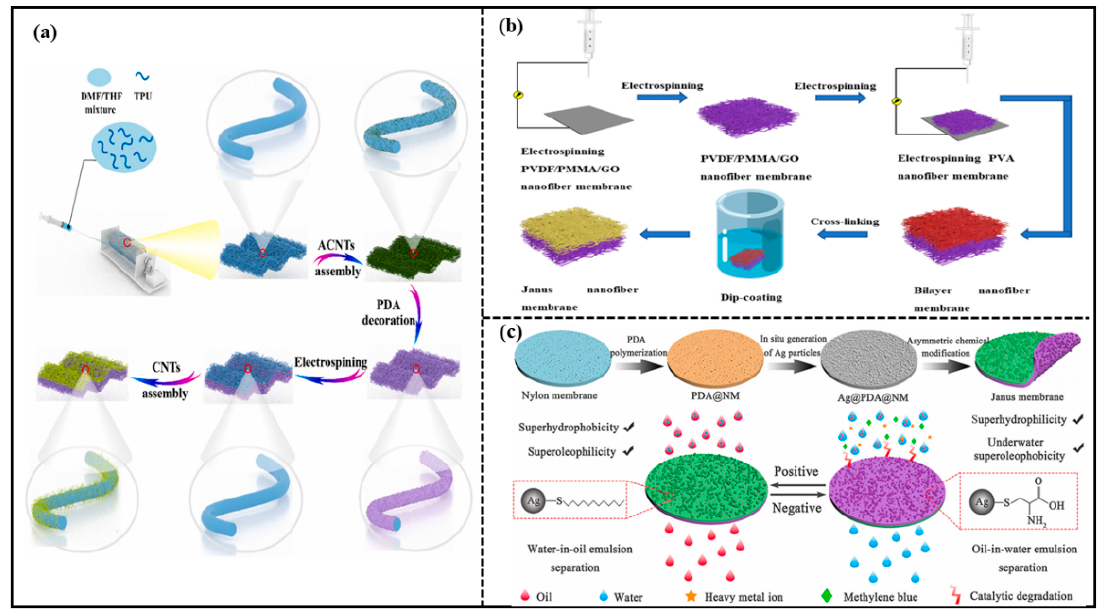
Figure 4. ( a ) Schematic demonstration of the overall preparation procedure of Janus membrane (JM). Reprint with permission from Ref. [42]. Copyright 2022, Elsevier. ( b ) schematic demonstration of Janus membrane preparation process. Reprint with permission from Ref. [43]. Copyright 2022, MDPI.; ( c ) schematic illustration for the fabrication and applications of Janus membrane. Reprint with permission from Ref. [48]. Copyright 2022, Elsevier.